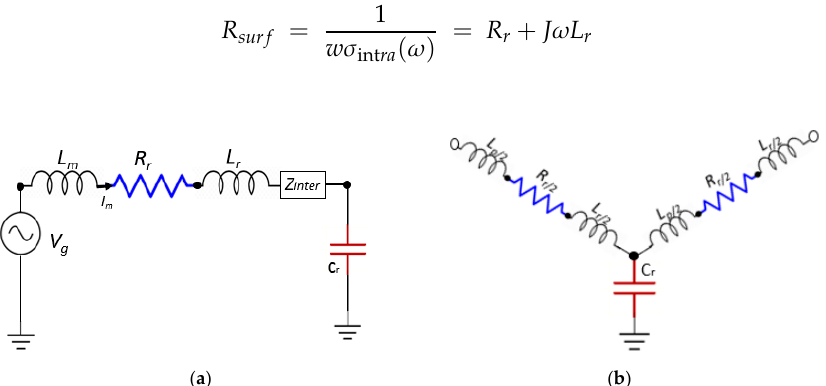
Figure 3. ( a ) Partial element equivalent circuit (PEEC) rectangular cell circuit model for graphene patch, where Vg represents the external bias voltage due to applied external electric field, Lm denotes the self-inductance, Rr, Lr and Zinter is due to graphene complex surface conductivity; and, ( b ) Unit cell model for the stacked graphene, where the two branches share the same node. 4.2. Resonant Frequency Calculation of Graphene Hexagone Based on PEEC Circuit Model